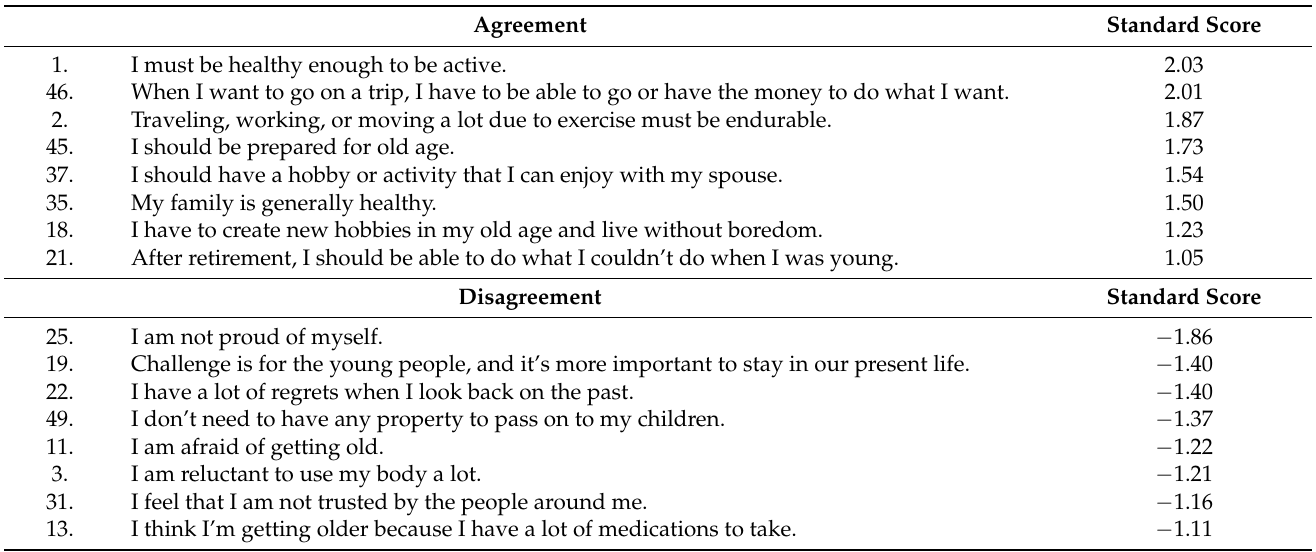
Table 5. The Q-statements with strong agreement or disagreement by Type 1.